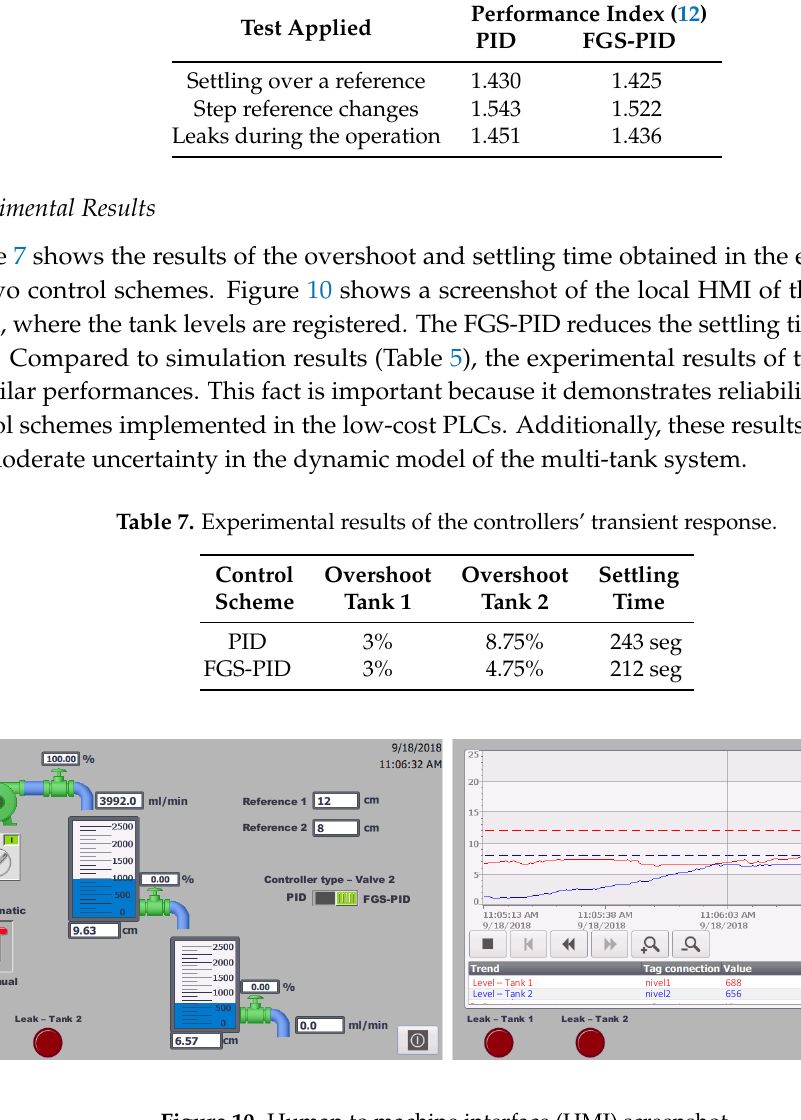
Figure 10. Human to machine interface (HMI)